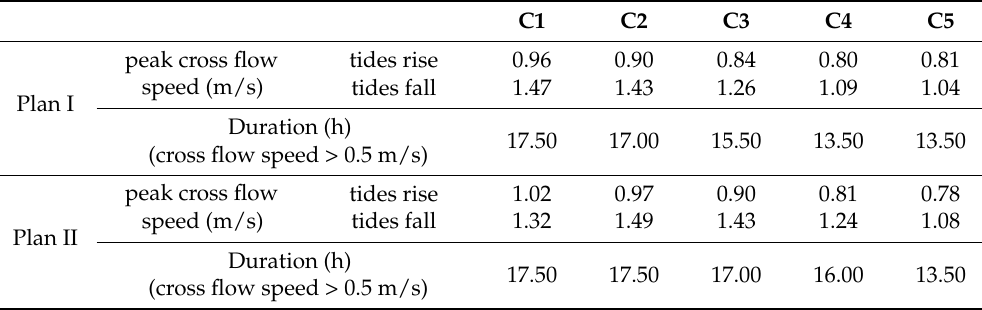
Table 5. Pre-engineering cross flow speed